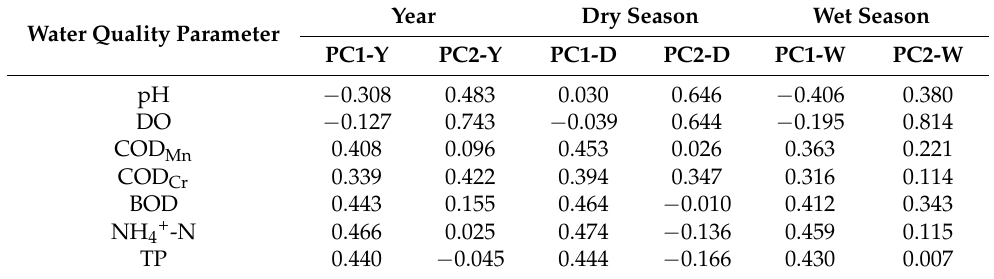
Table 6. Principal component loading matrix.